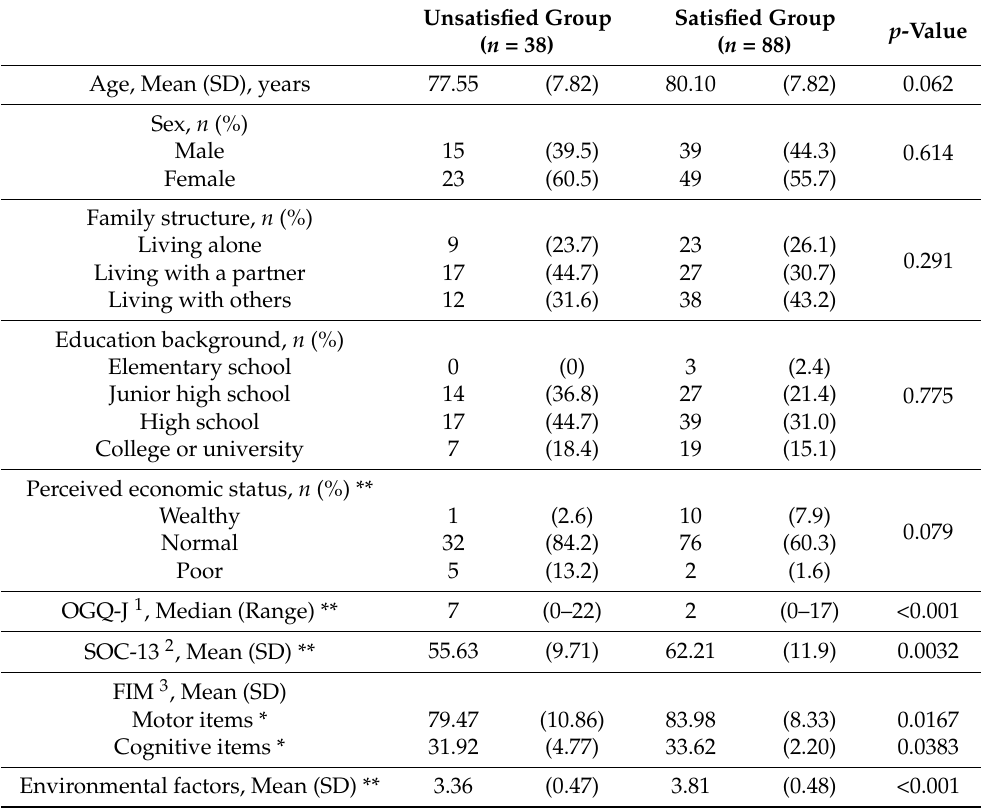
Table 2. Comparison of characteristics between unsatisfied group and satisfied group.